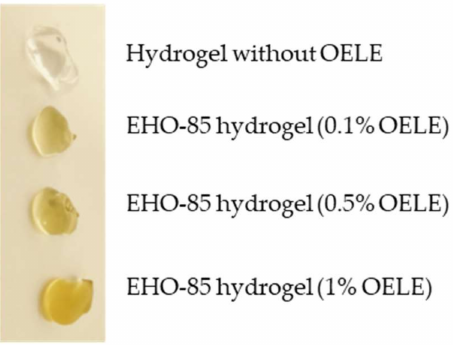
Figure 1. Visual appearance of the hydrogels with and without OELE at different concentrations. The intensity of the yellowish color varies according to the OELE